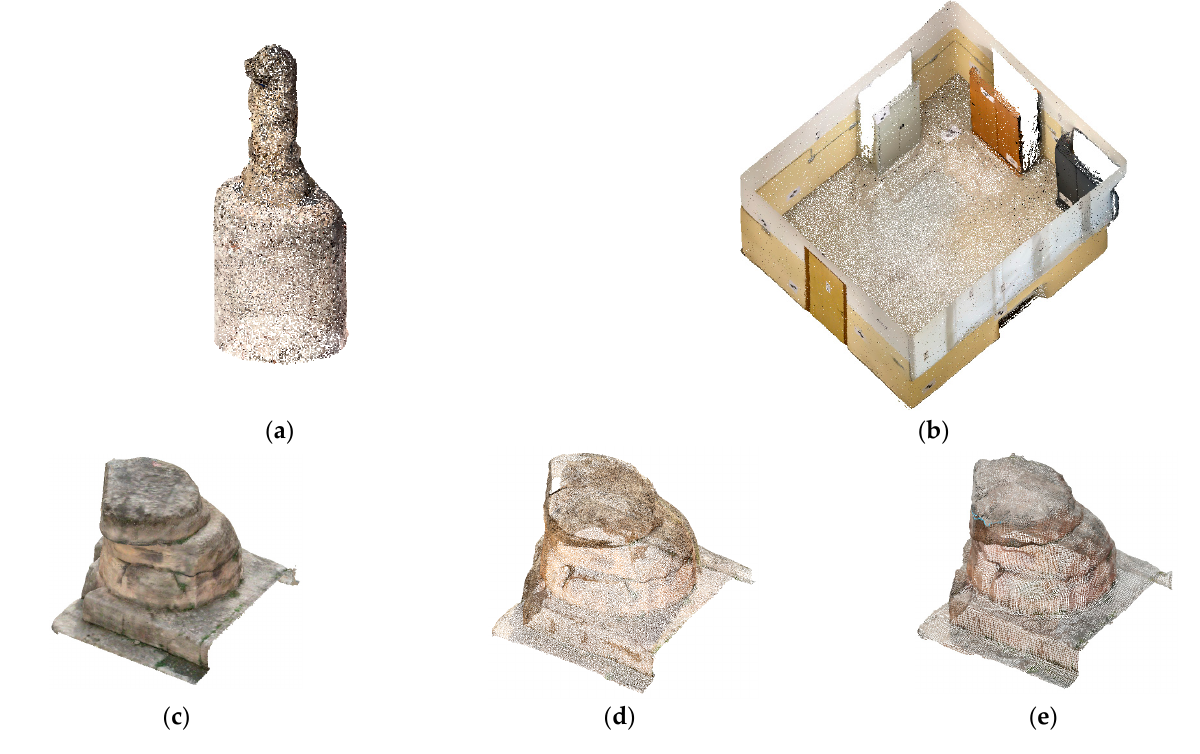
Figure A4. Examples of scans acquired in the second, third, fourth and fifth case studies: statue ( a ), room ( b ), the remains of a Doric column ( c – e ).